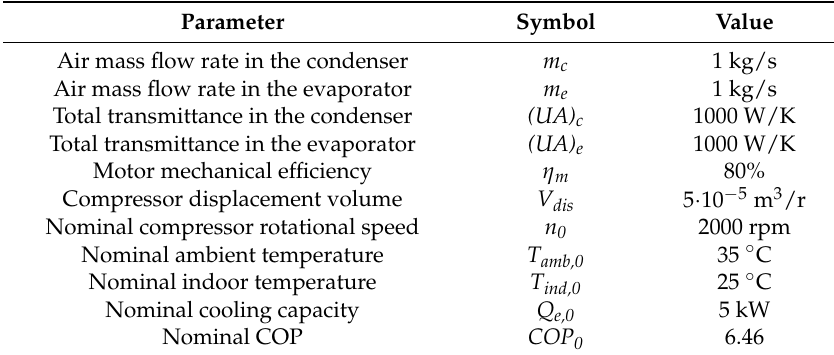
Table 2. Basic parameters of the examined system [30–34].